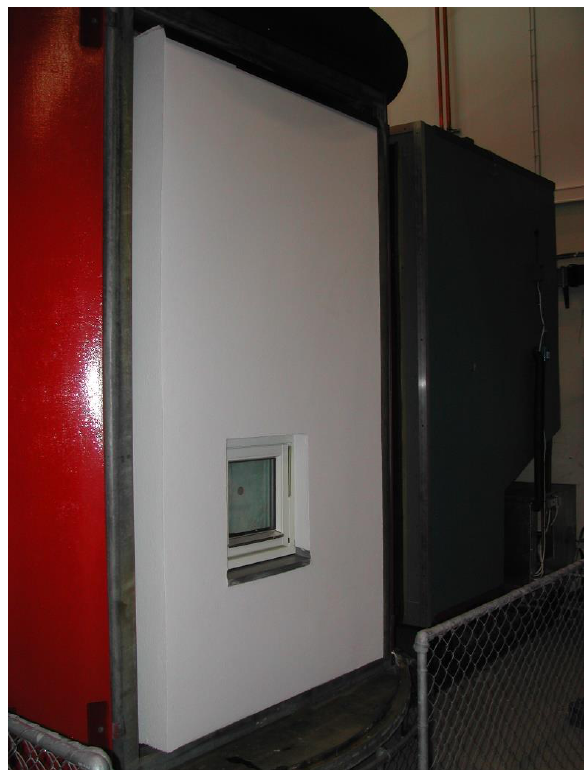
Figure 2. A large test area installed in SINTEFs climate simulator according to NT Build 495:2000 [17].